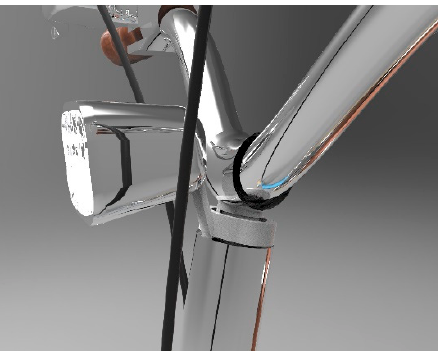
Figure 19. 3D model and rendering.